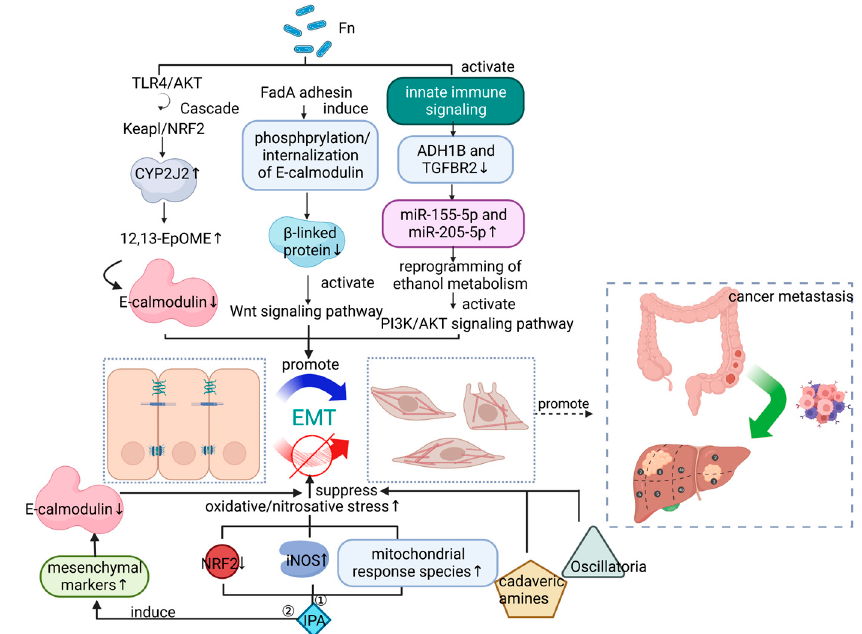
Figure 1. Microbiome affects cancer metastasis through epithelial–mesenchymal transition (EMT). Fn , Fusobacterium nucleatum ; ADH1B, alcohol dehydrogenase 1B; TGFBR2, transforming growth factor β receptor 2; IPA, indolepropionic acid. Figure created with BioRender.com on 14 January 2023.